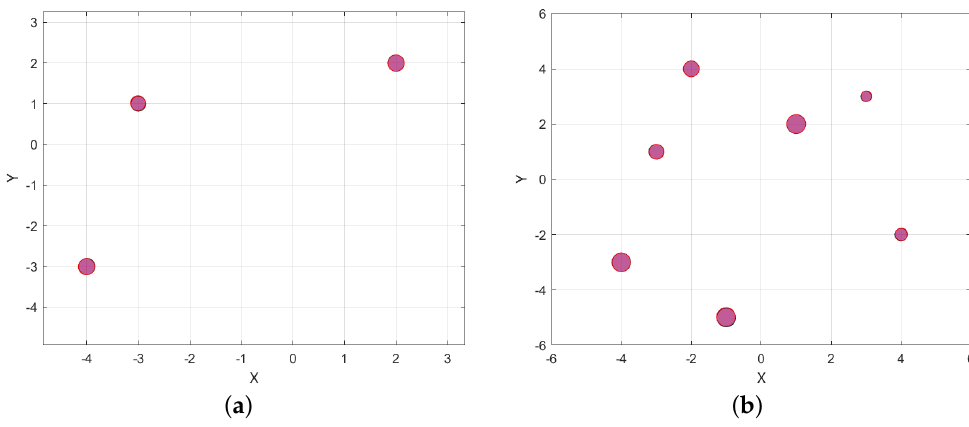
Figure 6. Reconstructed effect plots of the location and magnitude of multi-sources, where the number of multi-sources is three in ( a ) and the number of multi-sources is seven in ( b ).